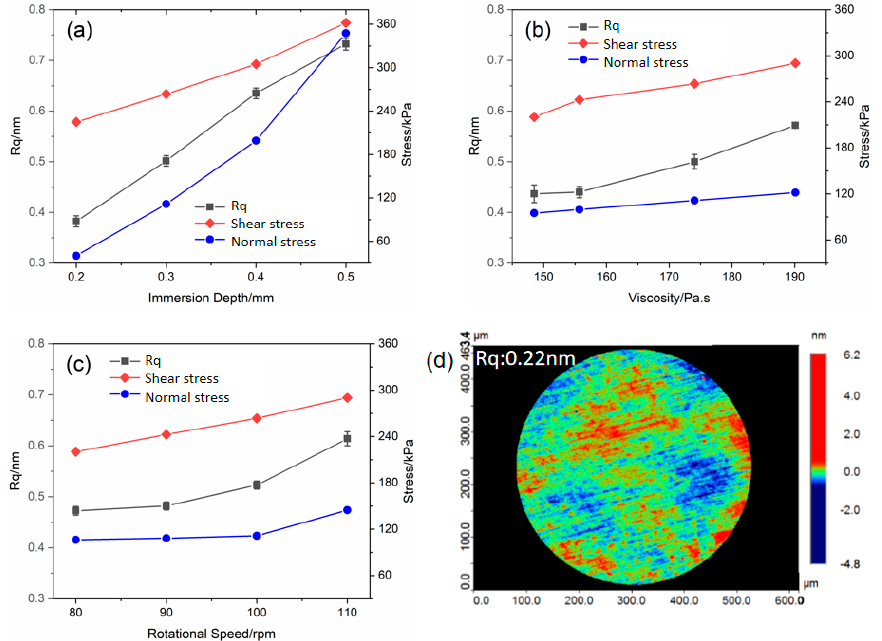
Figure 3. Relationships between surface roughness/peak shear stress/peak normal stress and process parameters including ( a ) immersion depth, ( b ) viscosity of MR fluid and ( c ) rotational speed. ( d ) Surface roughness of the FS under the determined process parameter.